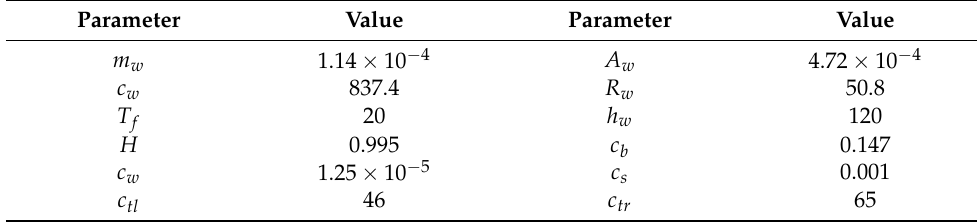
Table 1. Values of system parameters used in